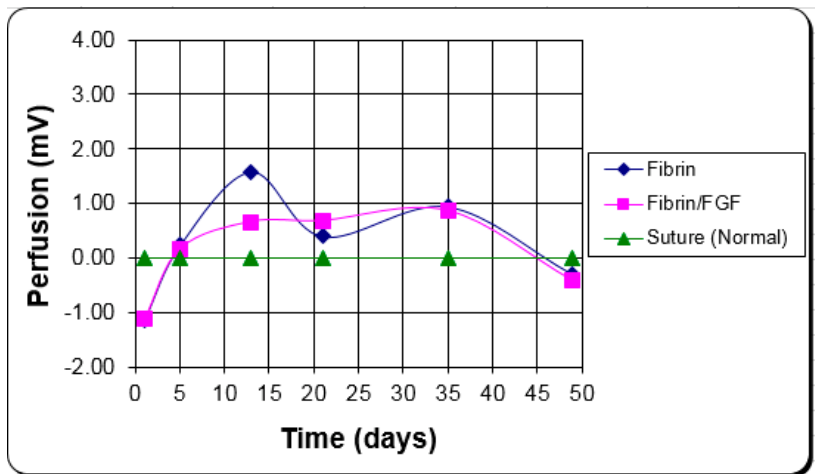
Figure 9. The average perfusion data for the clinical burn patients. The two fibrin treatments are scored relative to the sutured control [56].